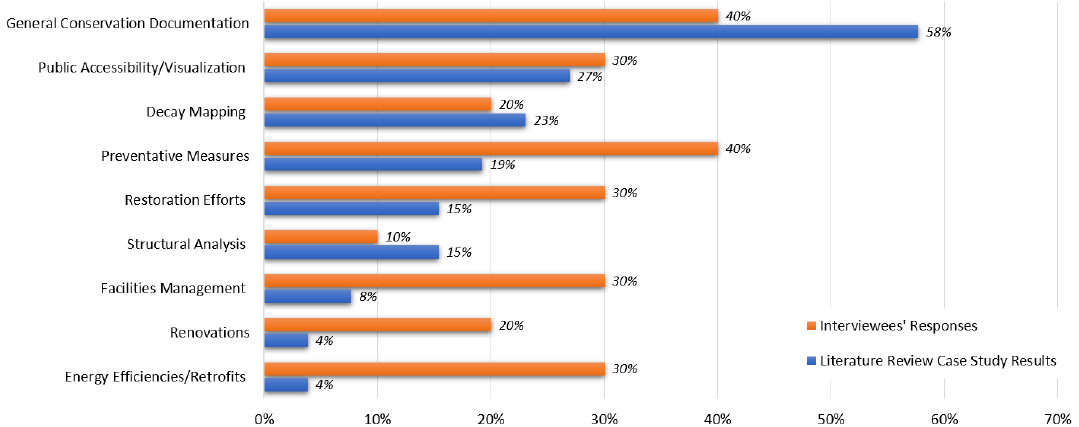
Figure 16. Interviewees’ primary perceived benefits of HBIM vs. the primary objectives identified in the 26 published HBIM case studies. Note: Interviewees were allowed to select multiple benefits.